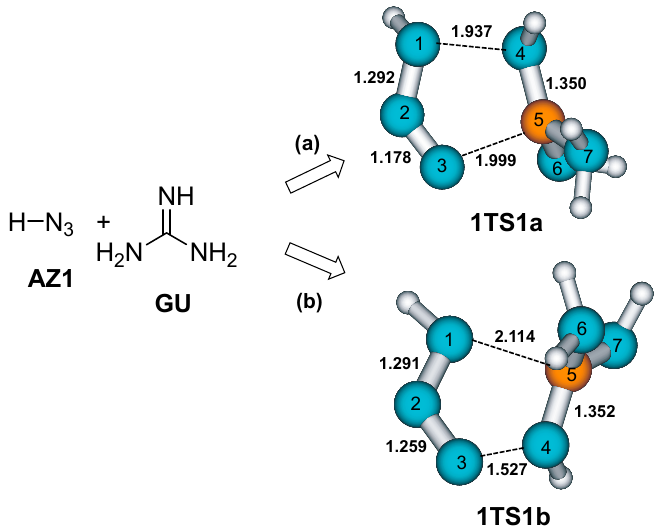
Figure 2. Transition state structures (bond lengths are given in Å) for two different modes of azide addition to the guanidine C=N bond. ( a ) addition mode (a); ( b ) addition mode (b). The direction (b) is energetically significantly more favorable, by 18.3 kcal mol − 1 ( E rel ( 1TS1b ) = 35.9 kcal mol − 1 vs. E rel ( 1TS1a ) = 54.2 kcal mol − 1 ) (Figure 3). Both processes are endothermic and the 5,5-diamino-1,4(or 2)-dihydro-1,2,3,4-tetrazole products are